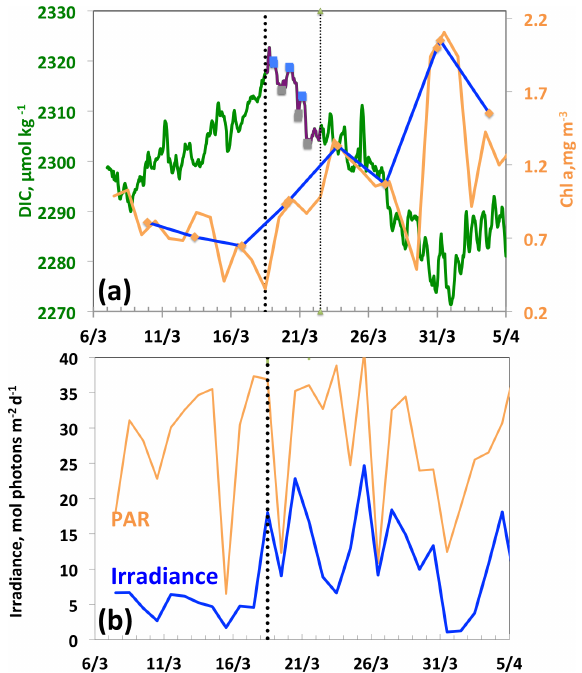
Figure 5. From 7 March to 5 April, (a) DIC and Chl a . The pur- ple line and the squares (blue, morning; grey, evening) indicate the 3d biological diurnal DIC changes during the period considered to compute NCP. The blue and orange lines indicate the surface Chl a when the glider was at a distance of less than 5km (blue) and less than 20km (orange), respectively, from the BOUSSOLE buoy. (b) PAR and I , average mixing-layer irradiance. The vertical dotted black line indicates the onset of the bloom on 18